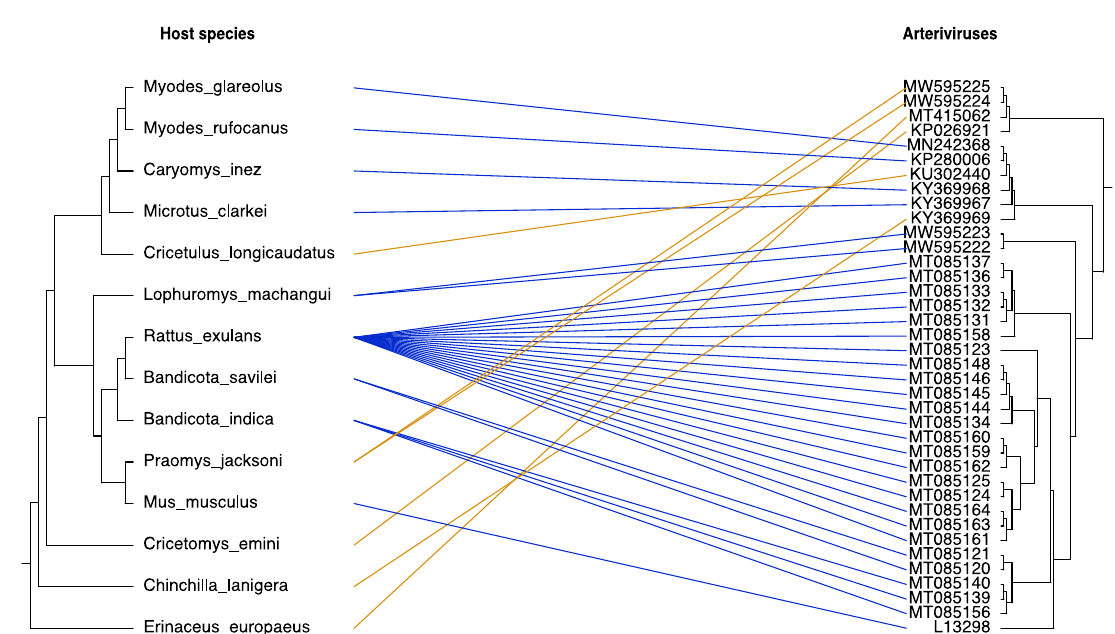
Figure 4. Tanglegram of arteriviruses and their rodent and hedgehog hosts. The host tree topology was inferred using the VertLife.org online tool (left phylogeny). The virus tree was constructed using the rodent-wide alignment with the addition of one hedgehog arterivirus sequence (right phylogeny). Interconnected lines represent the relationships between viruses and their hosts. Blue lines correspond to a phylogenetically congruent virus–host association, while orange lines highlight potential cross-species transmission events.